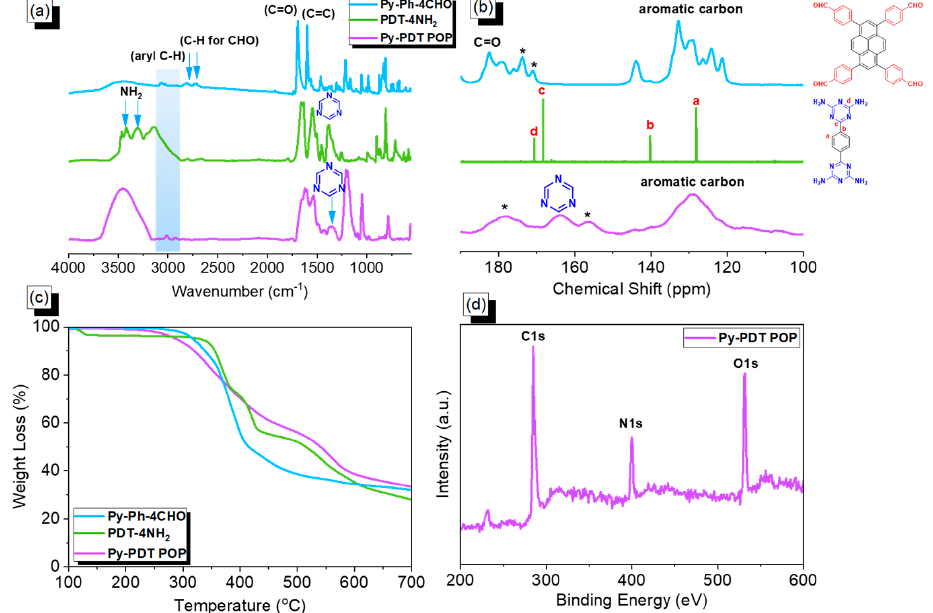
Figure 1. FTIR ( a ), ssNMR ( b ), and TGA ( c ) plots of Py-Ph-4CHO, PDT-4NH 2 , and Py-PDT POP, recorded at 25 ◦ C; ( d ) XPS pattern of Py-PDT POP. * is the side band of solid-state nuclear magnetic resonance spectroscopy (NMR).